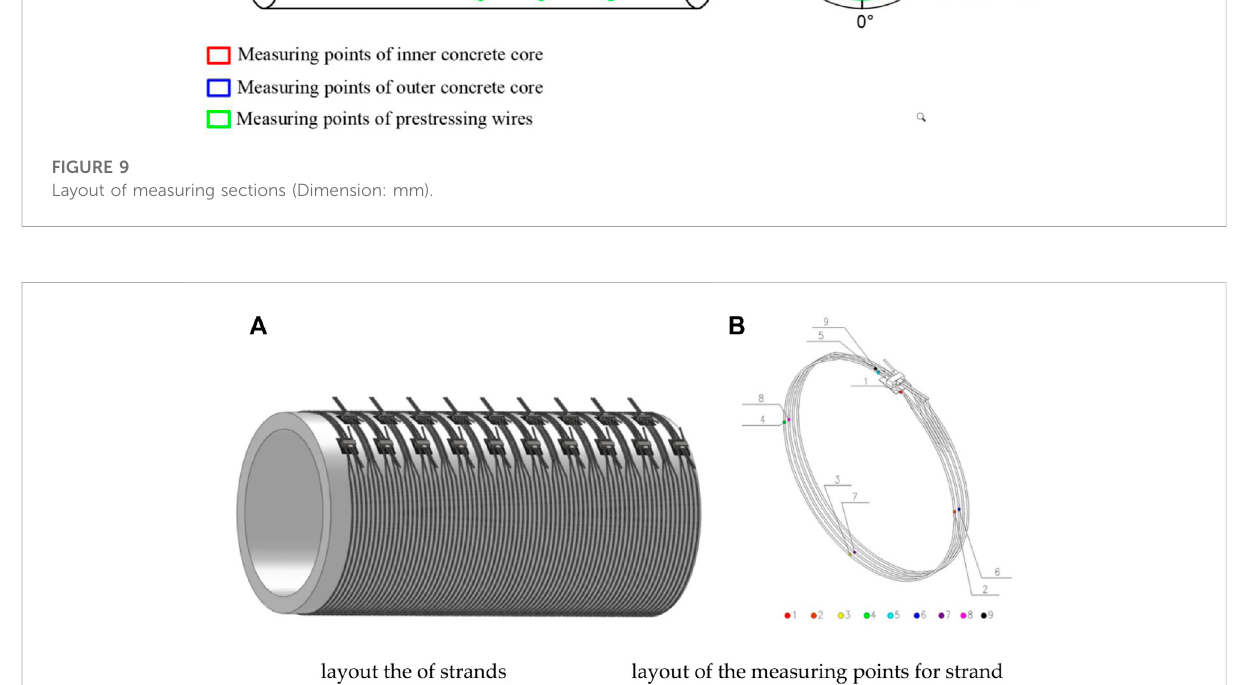
FIGURE 10 Details of the strands. (A) Layout of the strands and (B) layout of the measuring points for the strand.